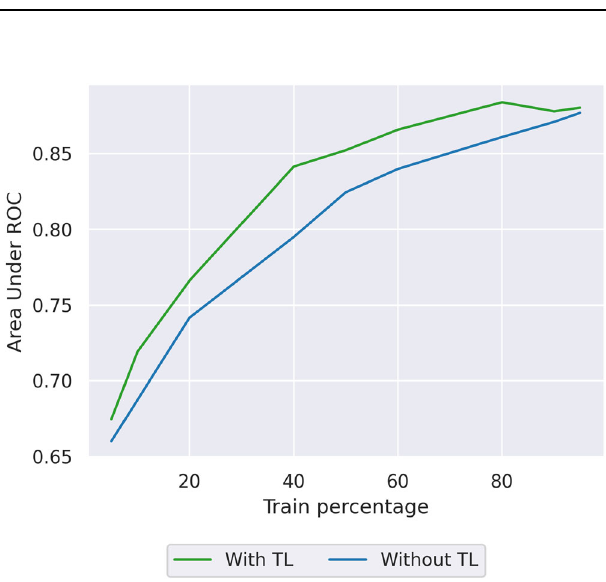
Fig. 1 AKI model performance as available data size varies, with and without extra features. Area under receiver operator curve (AUROC) of acute kidney injury (AKI) model performance against dataset size, with (blue line) and without (orange line) urine features. The model with urine features needs to be trained with about 20% of the dataset to achieve the same performance as the model without the urine features trained on 100% of the data, showing that there is a substantial restart cost when adding new features to a model in the absence of transfer learning. Source data is in Supplementary Data